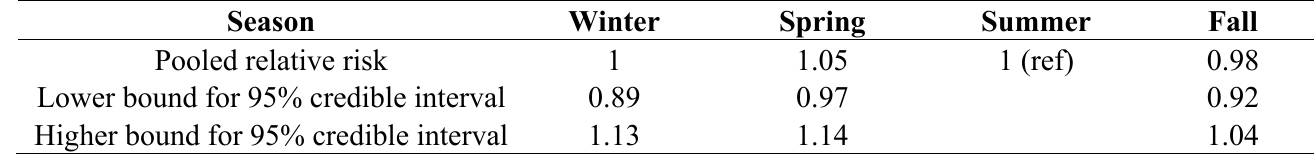
Table A15. Pooled relative risks and 95% credible interval for the association between season of conception and preterm birth.